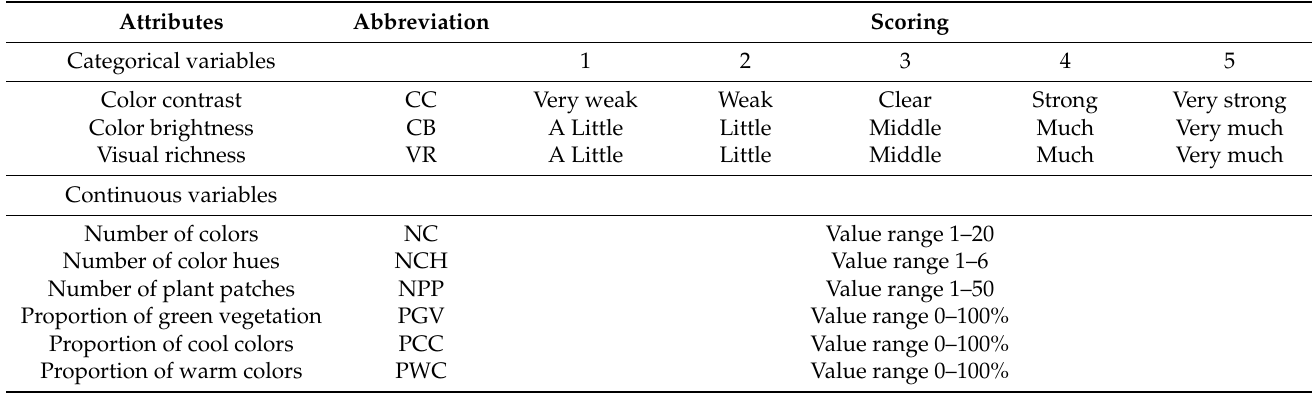
Table 1. Visual attributes of flower border including three categorical variables and six continuous